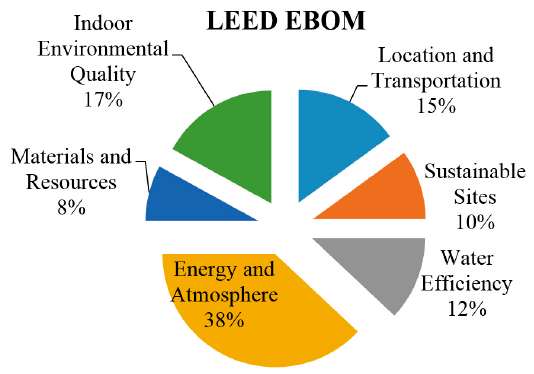
Figure 1. LEED EBOM aspects (Data Source: USGBC 2014).